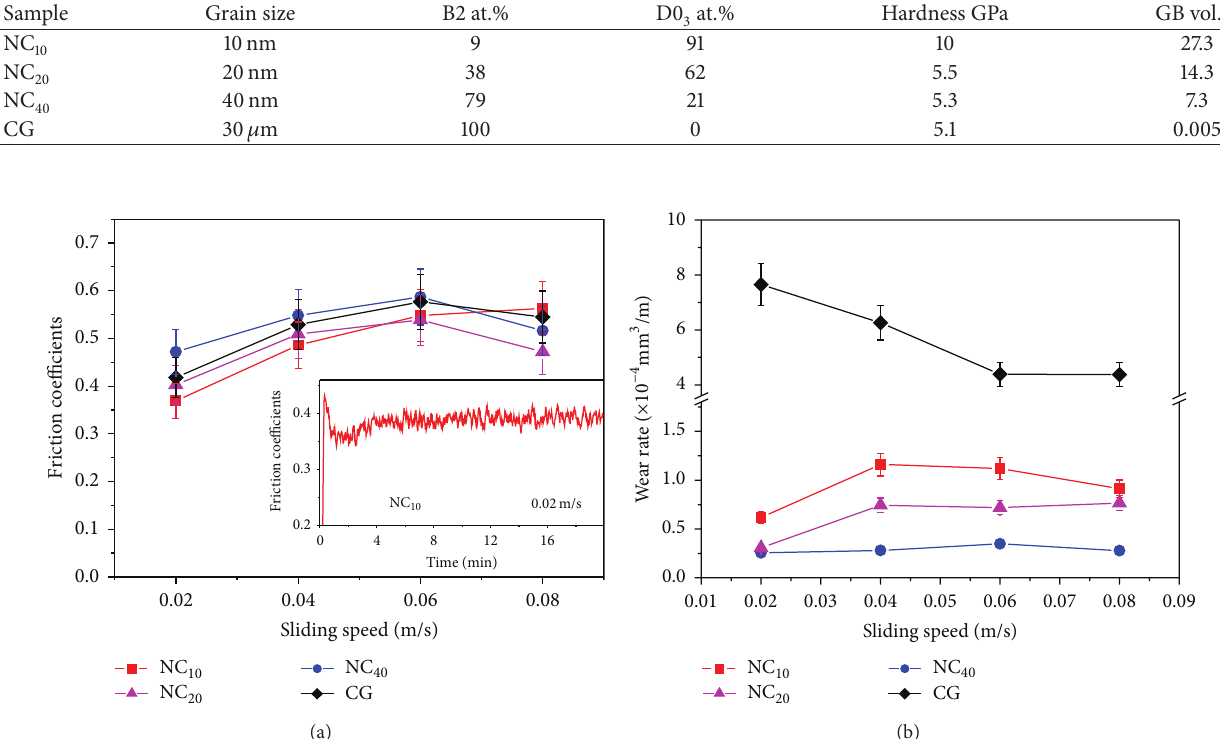
Figure 1: Average friction coefficients (a) and wear rates (b) of the Fe 88 Si 12 alloys as a function of speed; inset of (a) is evolution of friction coefficient of NC 10 as function of